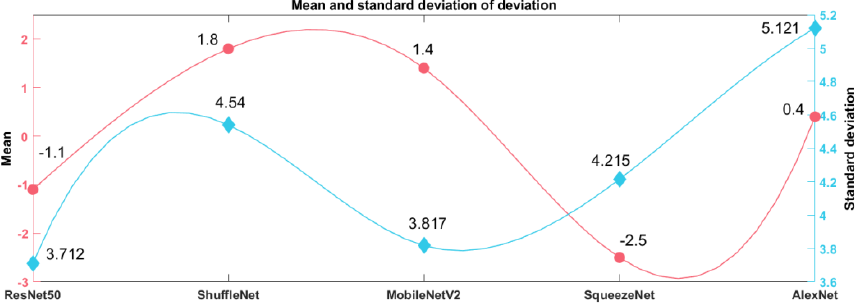
Figure 18. Statistical analysis of prediction results.